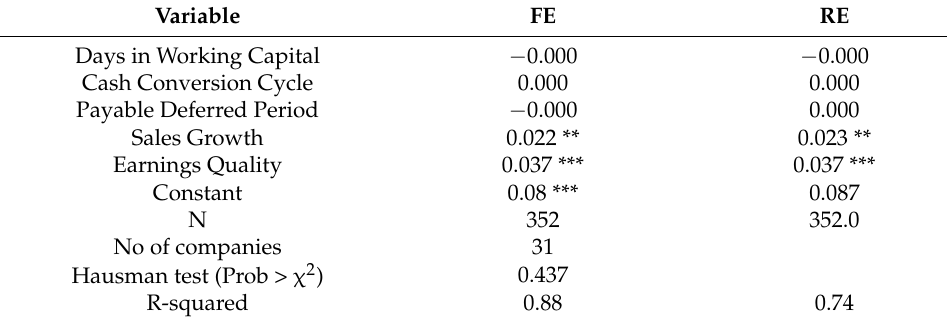
Table 5. Effect of WCM components on